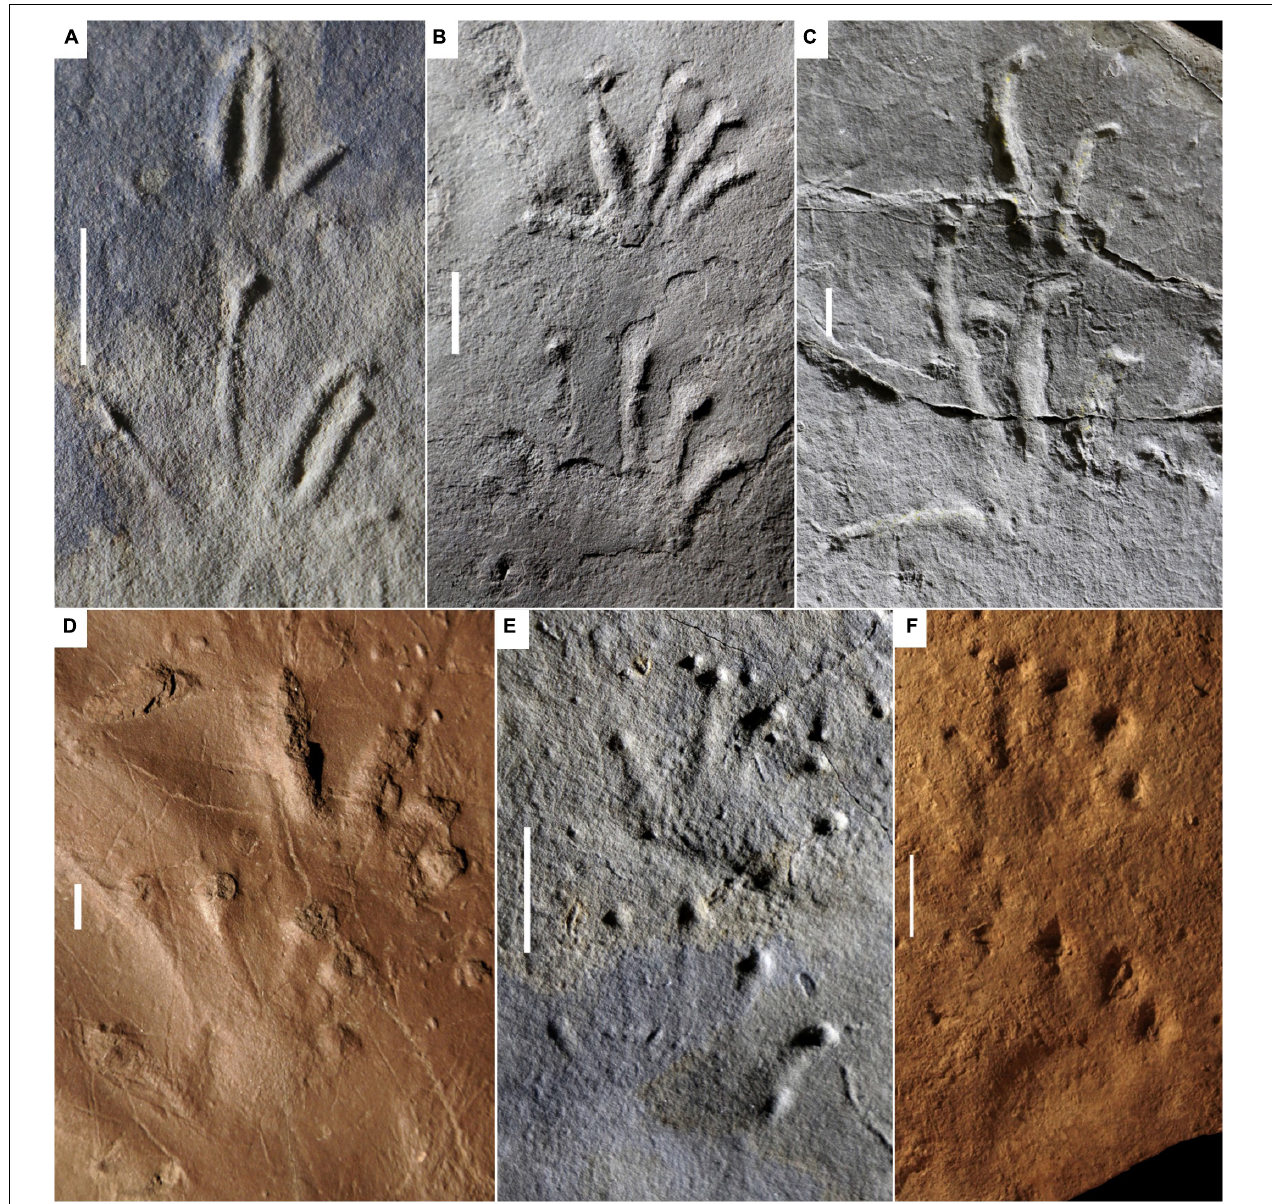
FIGURE 1 | Carboniferous ichnotaxa attributed to reptiles (A–C) and anamniote reptiliomorphs (D–F) . (A) NMMNH P-31746-7. Notalacerta missouriensis , right pes-manus couple, convex hyporelief. McAlester Formation, Oklahoma. (B) NSM 997 GF 30.6. Varanopus microdactylus , right pes-manus couple, convex hyporelief. Cape John Formation, Nova Scotia. (C) YPM 519. Dromopus lacertoides , left pes-manus couple, concave epirelief. Howard Limestone, Kansas. (D) NMMNH P-64276. Hylopus hardingi , right pes-manus couple, convex hyporelief. (E) NMMNH-NN 1. Amphisauropus kablikae , right pes-manus couple,